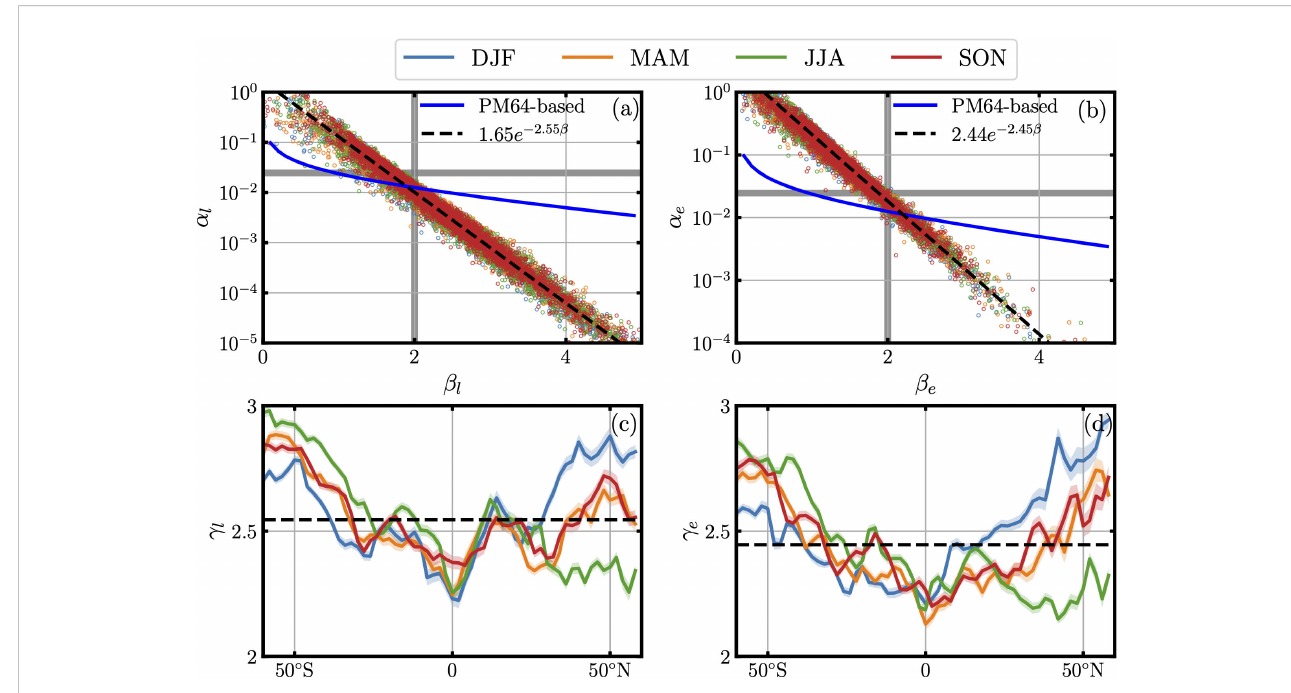
FIGURE 13 Relations between (A) a l and b l , (B) a e and b e . The dashed lines are the best fi ttings for the relation, the blue curve is the theoretical relation between a and b based on PM64 assumption. (C, D) are the meridional variations of the scaling exponents g l and g e , respectively, in which the dashed line is the average